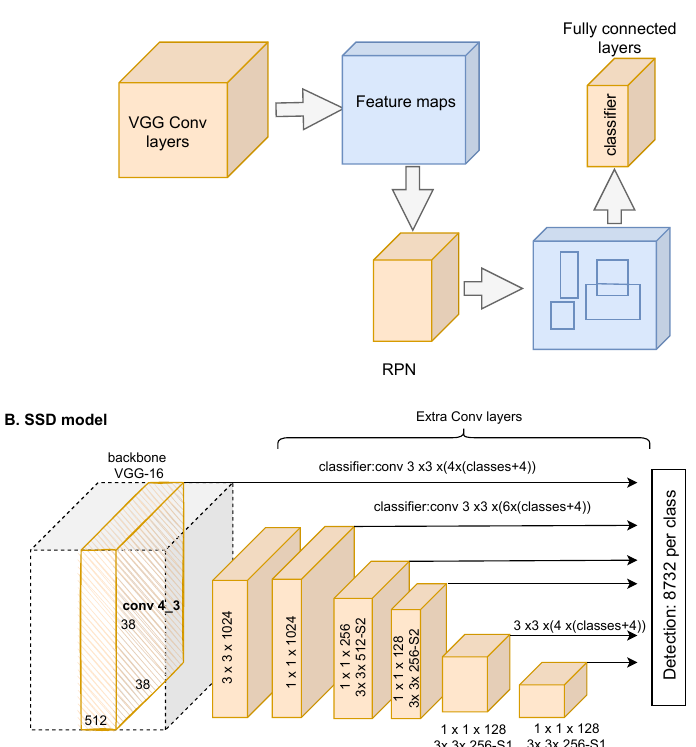
Figure 4. ( A ) Faster R-CNN model and ( B ) SSD model with VGG16 as the backbone. In the faster R-CNN, a series of convolutional layers (Conv layer) is used to extract features from the input, and then an RPN algorithm is used to find the region of interest, but in the SSD model the features and bounding box are extracted using only convolutional